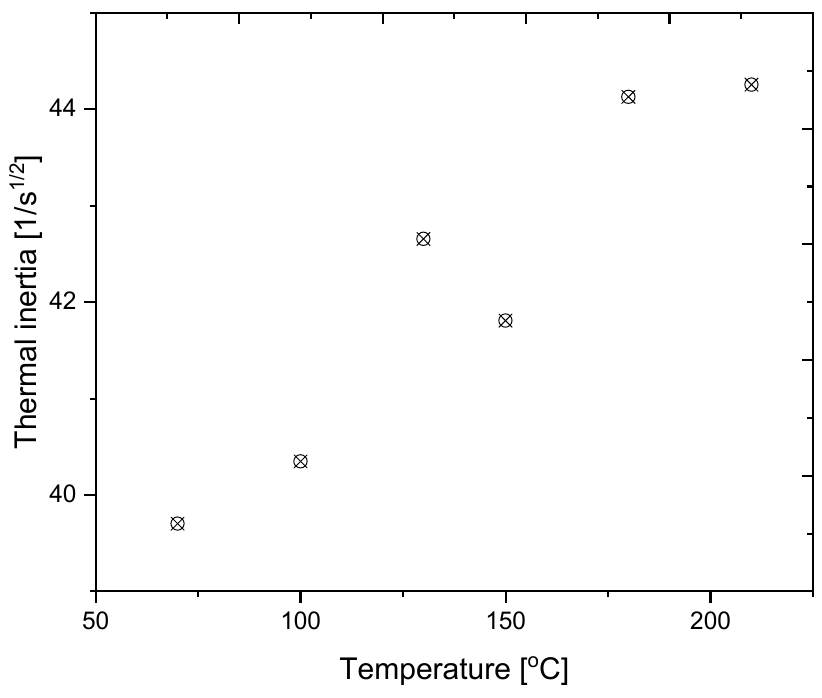
Figure 3. Thermal inertia as a function of temperature.